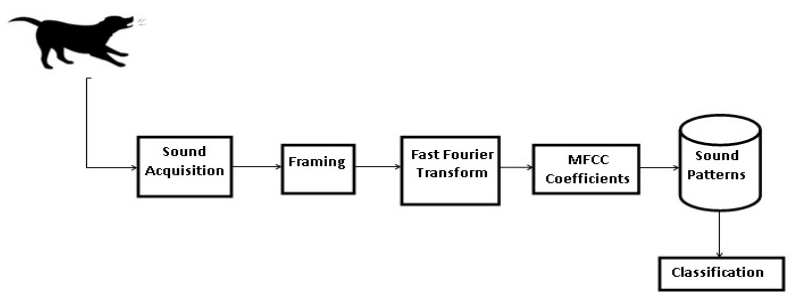
Figure 3. Proposed methodology for bark pattern classification.